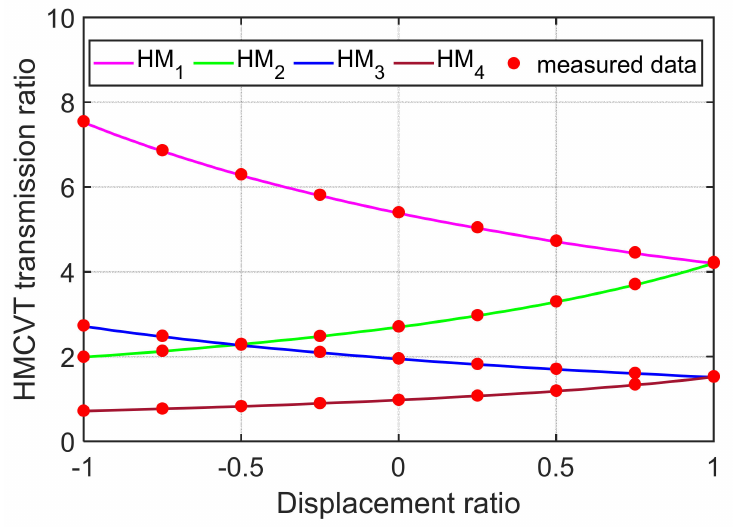
Figure 8. Verification results of transmission ratio characteristics.